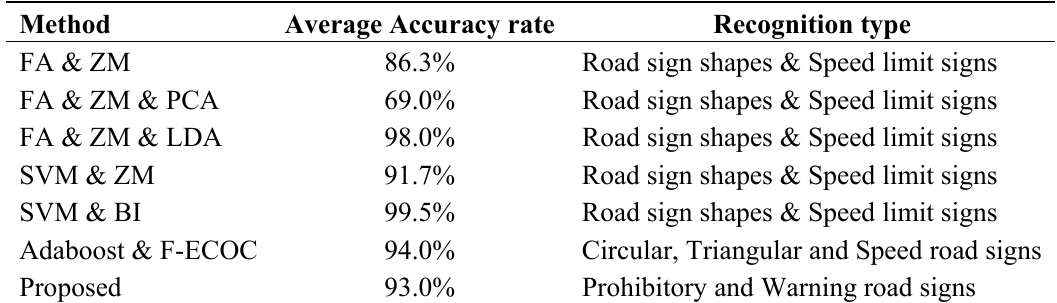
Table 7. The comparison with other methods for accuracy rate in static